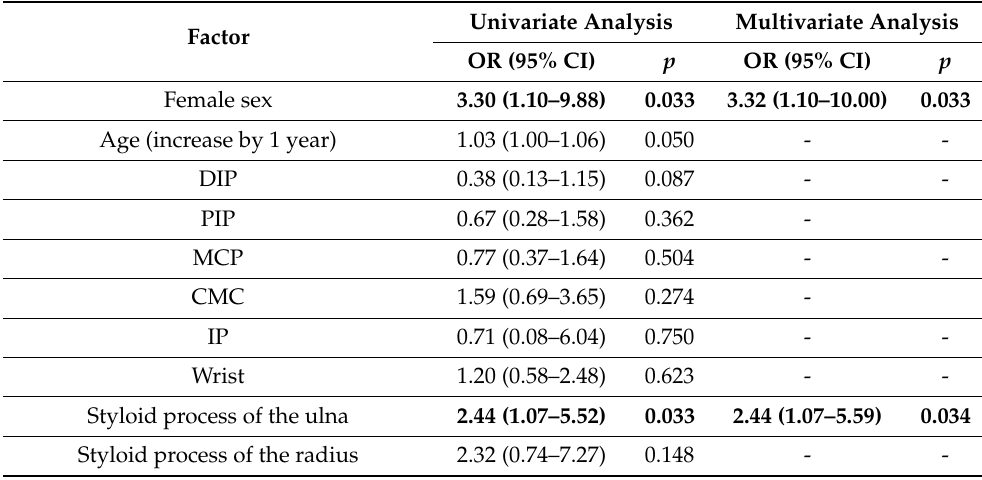
Table 12. Logistic regression for the dependent variable of seronegative RA vs. the independent variable of PsA considering the location of the lesions.